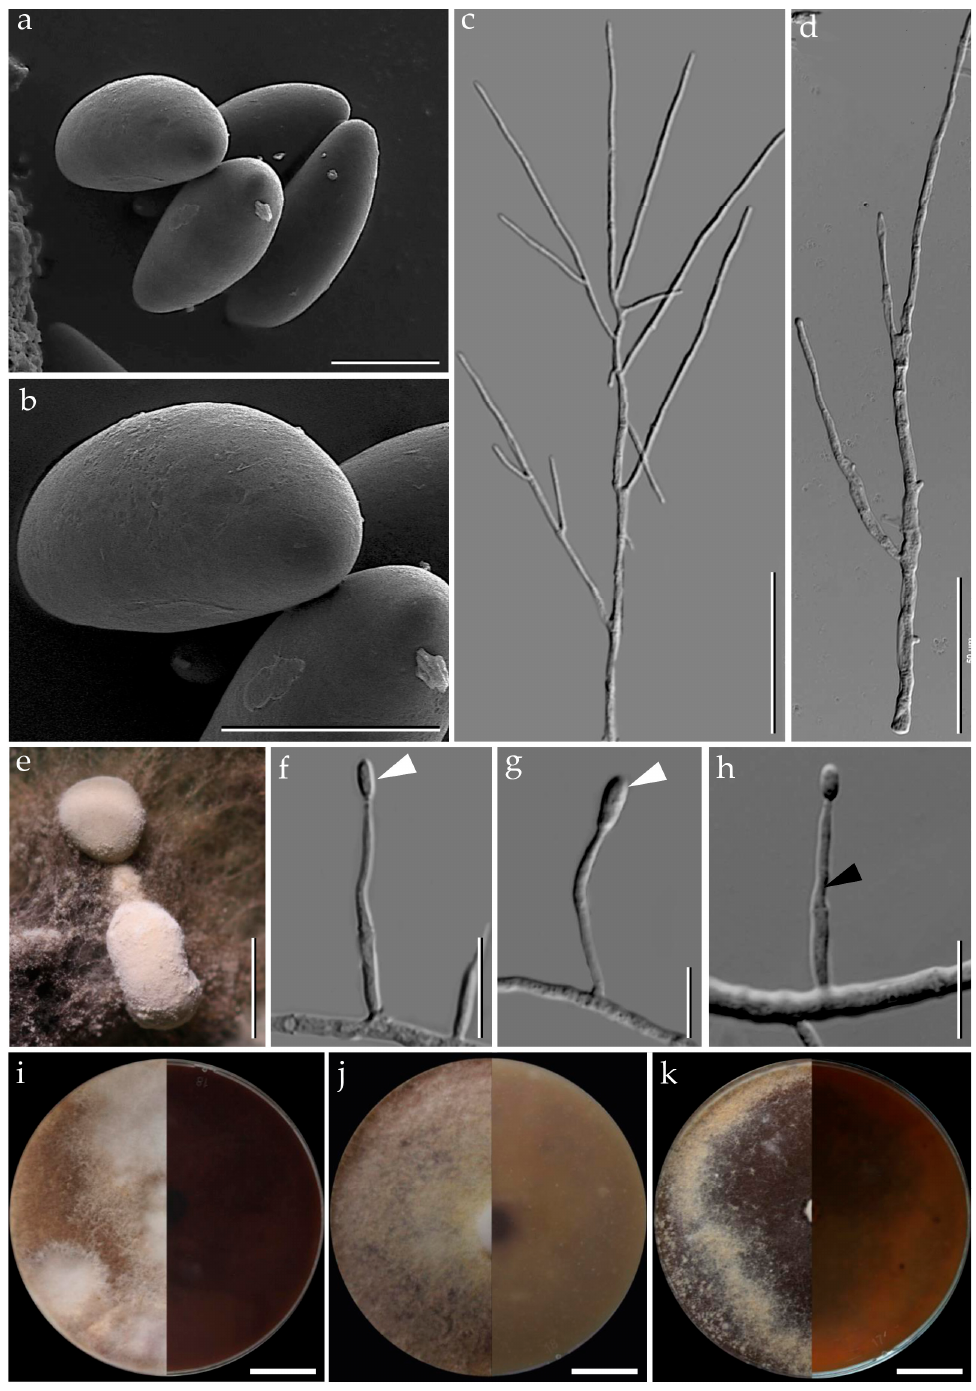
Figure 3. Pyrenopolyporus laminosus from Thailand (strain BCC89383). ( a , b ) Ascospores by SEM; ( c , d ) aerial mycelium showing branching pattern; ( e ) primordia in culture; ( f ) conidia (white arrows); ( h ) conidiogenous cell (black arrow); ( i ) colony on PDA after one month; ( j ) colony on OA after one month; ( k ) colony on YMGA after one month. Scale bars: ( a , b ) = 5 µm; ( c , d ) = 50 µm; ( e ) = 0.5 mm; ( f – h ) = 10 µm; ( i – k ) = 2 cm.